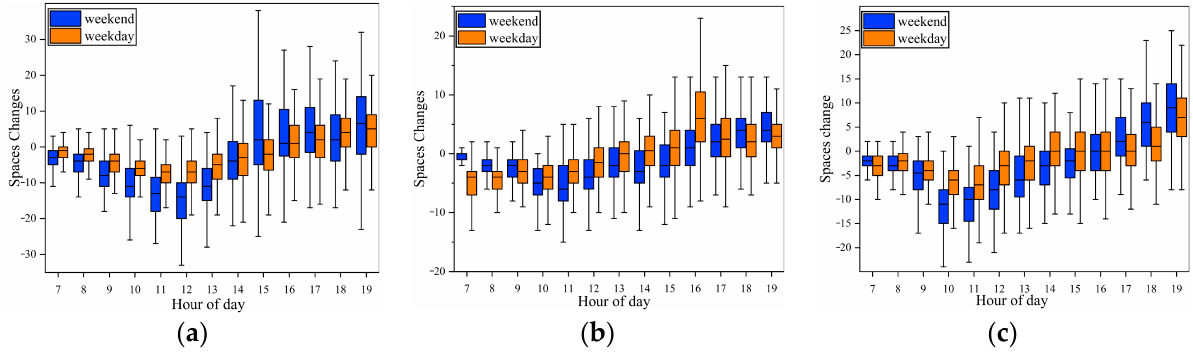
Figure 2. Impact of holiday events (weekdays or weekends) on VPS changes (7 AM to 7 PM). ( a ) Lot1 parking lot; ( b ) St5 parking lot; ( c ) St7 parking lot.